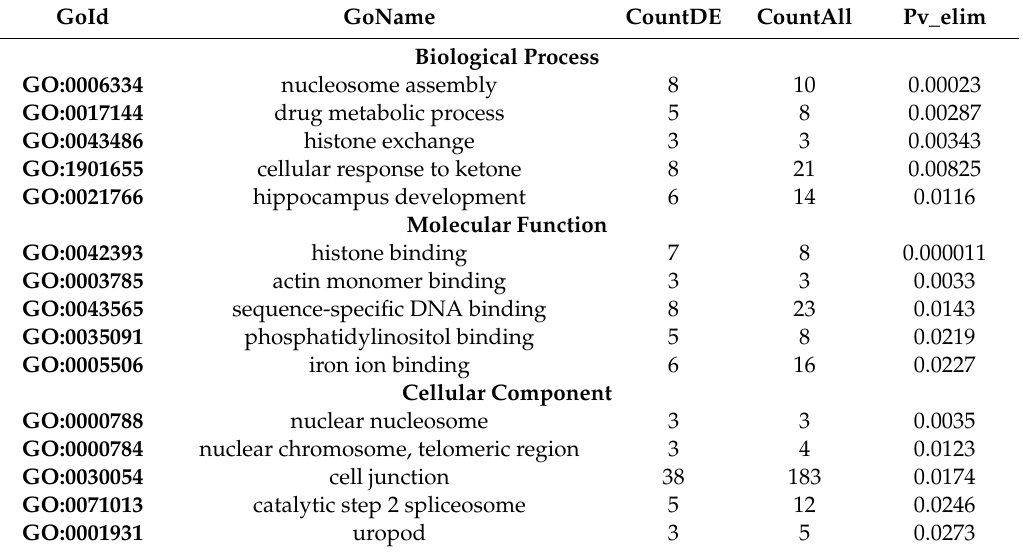
Table 4. GO terms enriched in